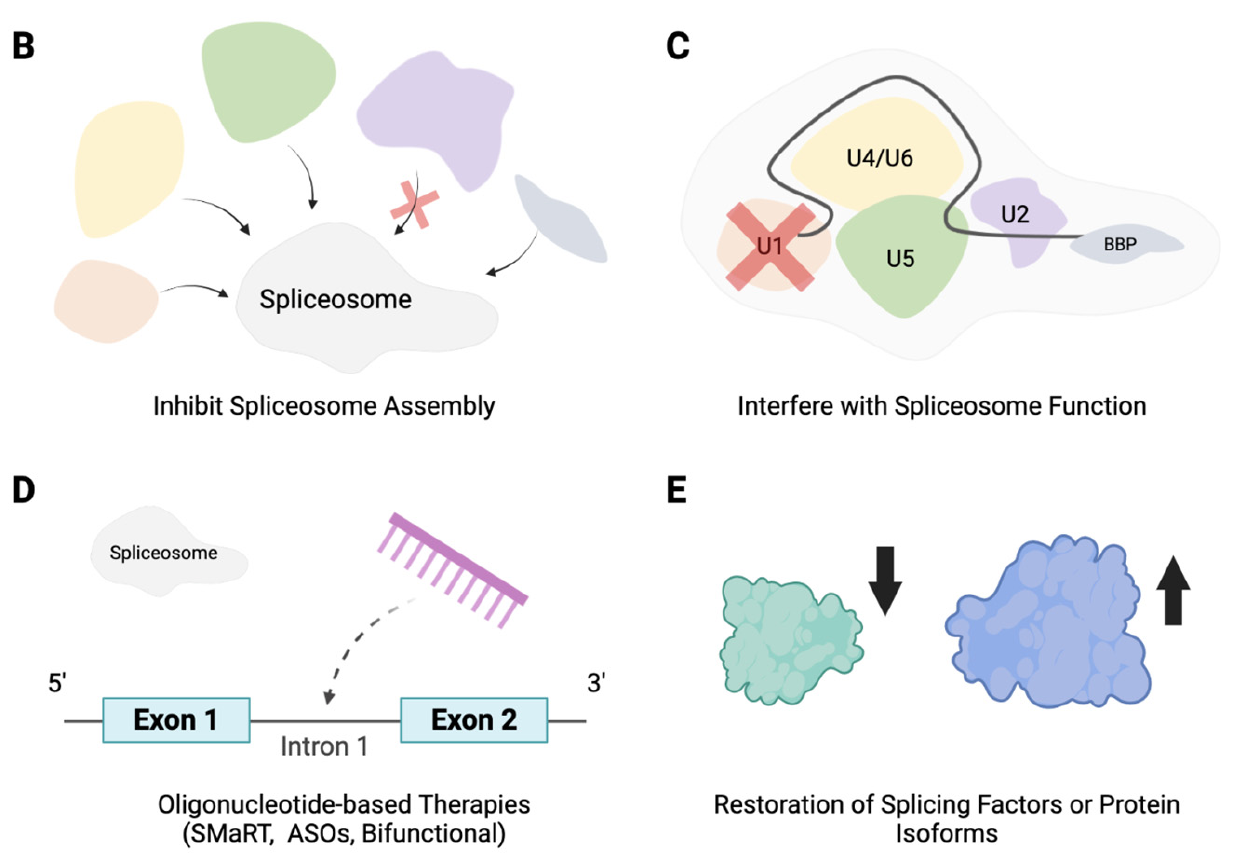
Figure 2. A schematic diagram simplifying the process of alternative splicing as well as depicting potential therapeutic strategies to mitigate mis-splicing. Briefly, the spliceosome, consisting of five crucial small nuclear ribonucleoproteins, as displayed in the figure, alongside other proteins catalyzes the splicing of pre-mRNA. Through coordinating the use of splice sites, the retention or exclusion of exons and any intron inclusion, alternative splicing results in the synthesis of multiple protein isoforms from one gene transcript ( A ). Aberrant alternative splicing has been shown to have a critical role in the pathogenesis of numerous diseases, consequently the design and development of therapeutics able to mitigate mis-splicing has emerged as a popular area of research. Two promising strategies that recently emerged revolve around the elucidation of compounds with the ability to obstruct the spliceosome. These include searching for drugs with the ability to inhibit spliceosome assembly or the interference of spliceosome function, as can be seen in ( B , C ). Moreover, the use of oligonucelotides as therapeutics, including spliceosome-mediated RNA trans-splicing (SMaRT) technologies, antisense oligonucleotides (ASOs) and bifunctional oligonucleotides, has attracted significant attention due to their ability to be designed to bind to a complementary sequence and trigger either the activation or inhibition of splicing events by sterically blocking or recruiting effectors to promote splicing ( D ). Similarly designing therapeutic strategies to restore the natural balance of splicing factors or generated spliced isoforms has shown great promise to reverse the disease phenotype and is therefore another encouraging therapeutic avenue to target mis-splicing ( E